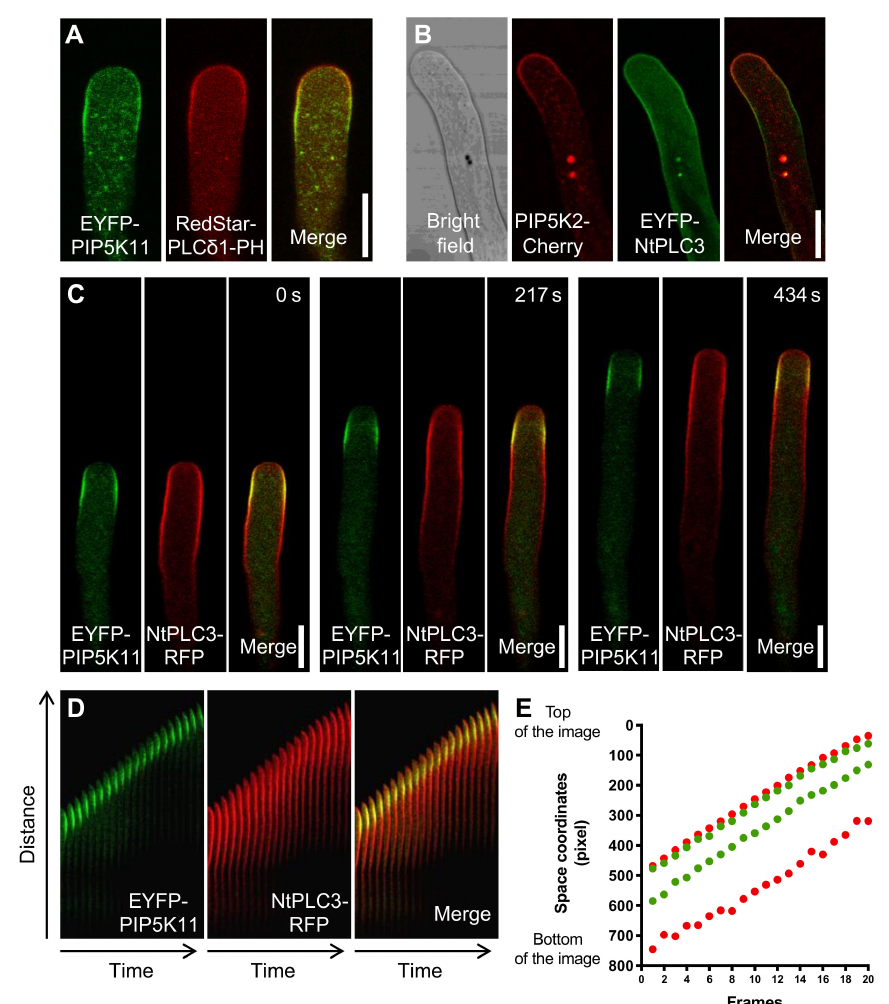
Figure 1. NtPLC3 localizes to a subapical plasma membrane domain encompassing domains occupied by PIP5K2 or PIP5K11. The localization of NtPLC3 was monitored by confocal imaging upon transient expression in tobacco pollen tubes. For these localization studies, expression levels were kept low to minimize morphological changes of the pollen tube cells. ( A ) Coexpression of EYFP-PIP5K11 with RedStar-PLC δ 1-PH, a fluorescent biosensor for PtdIns(4,5)P 2 , as indicated. B-E, Association of fluorescence-tagged NtPLC3 with an extended subapical plasma membrane domain, which spans the region occupied by coexpressed PIP5K2-mCherry or EYFP-PIP5K11. ( B ) Coexpression of EYFP-NtPLC3 with PIP5K2-mCherry. ( C ) Coexpression of NtPLC3-RFP with EYFP-PIP5K11, monitored in a time lapse experiment. The time series shown was recorded for 600 s at a frame rate of 2.14 frames min -1 . Three selected frames are shown, as indicated. ( D ) Kymograph analysis of median confocal LSM sections of a growing pollen tube from (C), indicating the dynamic relative movements of PIP5K2-EYFP (green) and NtPLC3-RFP (red). Right panel: merged images (overlap indicated by yellow). ( E ) Intensity and distribution of the EYFP-PIP5K11 (green) and NtPLC3-RFP (red) signals were further analyzed by the machine learning program Ilastik to provide nonbiased results. Note that the relative distances from the pollen tube tip are roughly constant, and that the region occupied by NtPLC3-RFP continuously spans the region occupied by PIP5K2-EYFP. Data are representative for five independent experiments. Scale bars = 10 µ